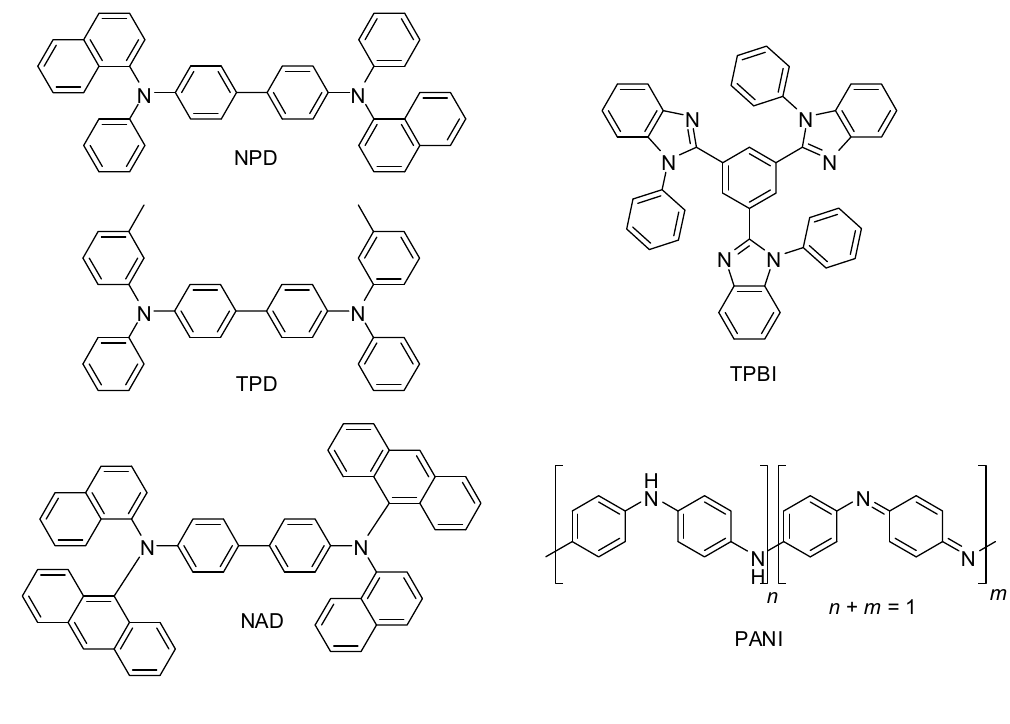
Figure 1. Chemical structures of compounds used for hole transport (NPD, NAD, TPD) and electron transport (TPBI) in OLED devices, and the conducting polymer polyaniline (PANI).